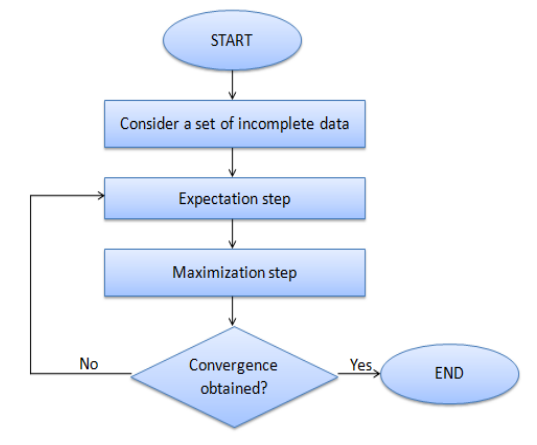
Fig. 18. Expectation-maximization algorithm.